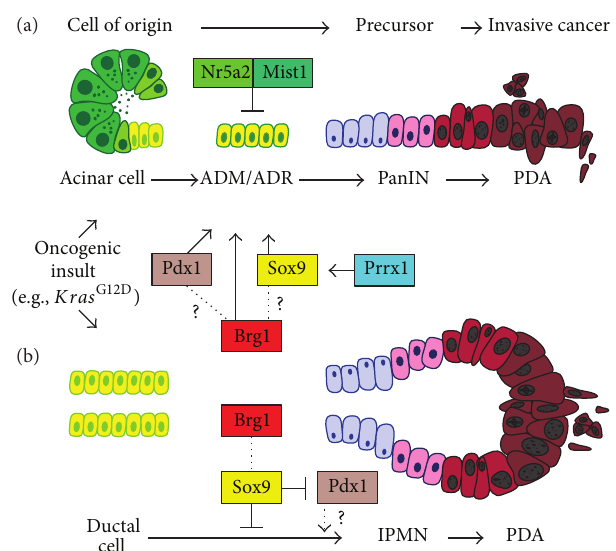
Figure 1: A model for developmental factors regulating acinar and duct cell transformation. (a) Acinar cells undergo acinar to ductal reprogramming (ADM/ADR) on their way to become PanINs and PDA. The ductal reprogramming of acinar cells is inhibited by factors that maintain stable acinar differentiation, such as Mist1 and Nr5a2. Instead, the transcription factors Sox9 and Pdx1 promote ductal reprogramming. Prrx1 and the chromatin remodeler Brg1 also promote ductal reprogramming, possibly by regulating other transcription factors, such as Sox9 or Pdx1. (b) Ductal cells transform into IPMN lesions by undergoing a dedifferentiation step (“ductal retrogression”) evidenced by an upregulation of the progenitor marker Pdx1. The chromatin remodeler Brg1 suppresses ductal retrogression by regulating Sox9 expression, which in turn inhibits Pdx1. This points to an opposing function of Brg1 in acinar versus duct cell transformation.